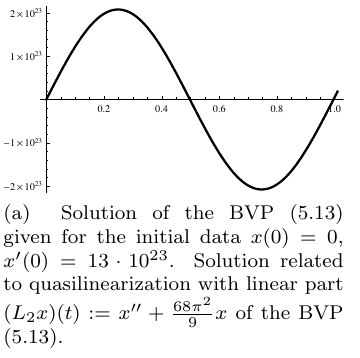
Figure 2. Different solutions of the BVP